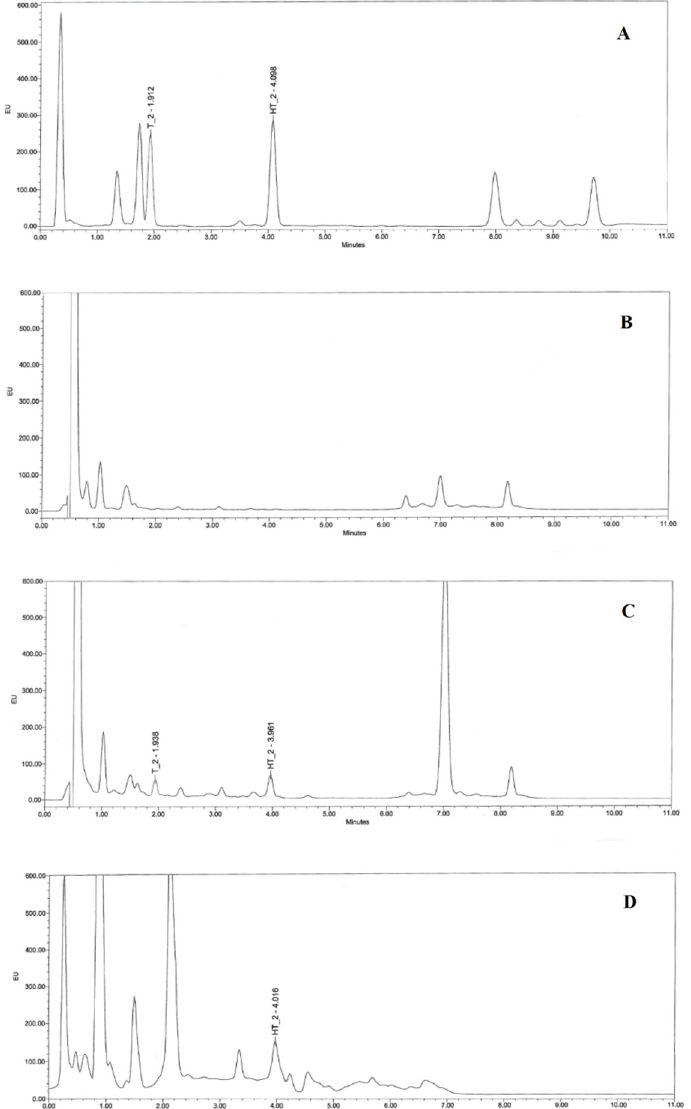
Figure 2. Chromatogram examples: T-2 and HT-at concentration of 500 μ g L − 1 ( A ); corn “blank” sample with no residues of T-2 and HT-2 toxins ( B ); corn samples fortified with 250 μ g kg − 1 of T-2 and HT-2 toxins ( C ); and corn sample naturally contaminated: 315.9 μ g kg − 1 of HT-2 toxin ( D ).